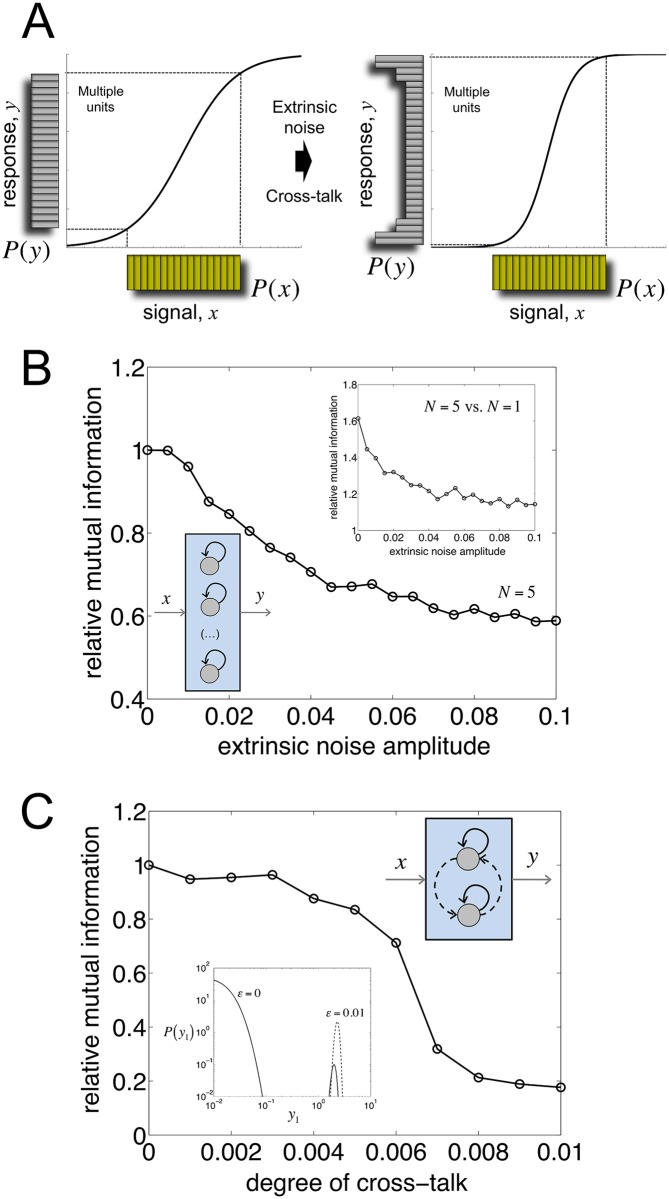
Extrinsic noise and cross-talk among redundant copies limit information transfer.(A) Input/output distributions depicting information transfer. Correlation among individual gene responses due to extrinsic noise or cross-talk reduces the response alphabet, and generates a less linear averaged stimulus-response profile (black curve, see Fig 2A for comparison). (B) Dependence of mutual information (MI) with the strength of extrinsic noise (Materials and Methods). Relative MI is with respect to absence of extrinsic noise. For this plot, we considered a system of N = 5 bistable units implemented with positive feedback. The inset shows a direct comparison between N = 1 and N = 5, emphasizing that MI increases with N. (C) Dependence of MI with the degree of cross-talk for the same regulatory system, but now constituted by N = 2 units. Relative MI is with respect to the situation without cross-talk. The inset presents the marginal probability distribution of gene expression of one unit (y1) in the absence and presence of cross-talk (parameterized by ε = 0 and ε = 0.01, respectively; see Materials and Methods) for the mean value of the input signal (x). Note that when the units are coupled, gene expression becomes unimodal (dashed curve).